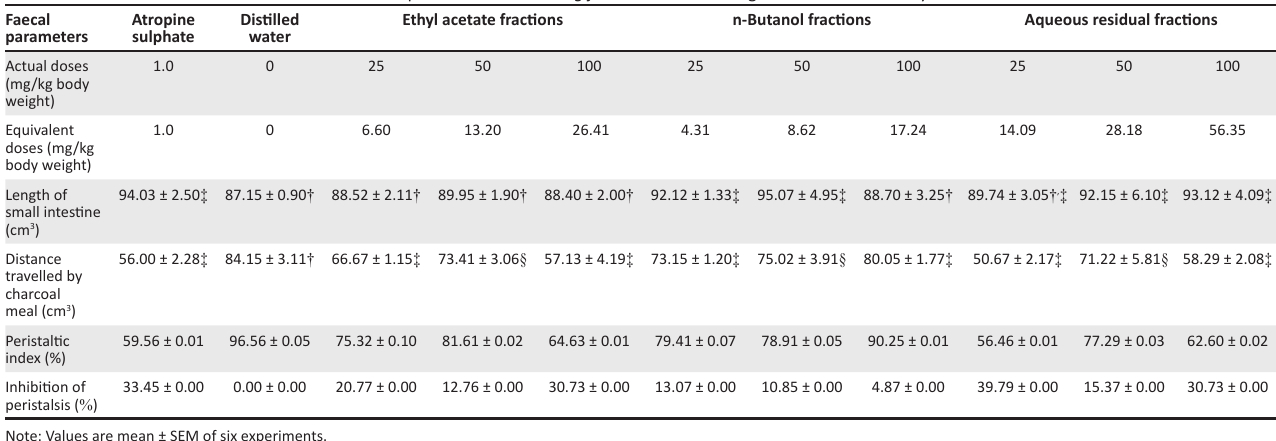
TABLE 3: Effects of the solvent–solvent fractions of aqueous extract of Mangifera indica leaves on gastrointestinal motility of the female Wistar rats. Faecal Atropine parameters